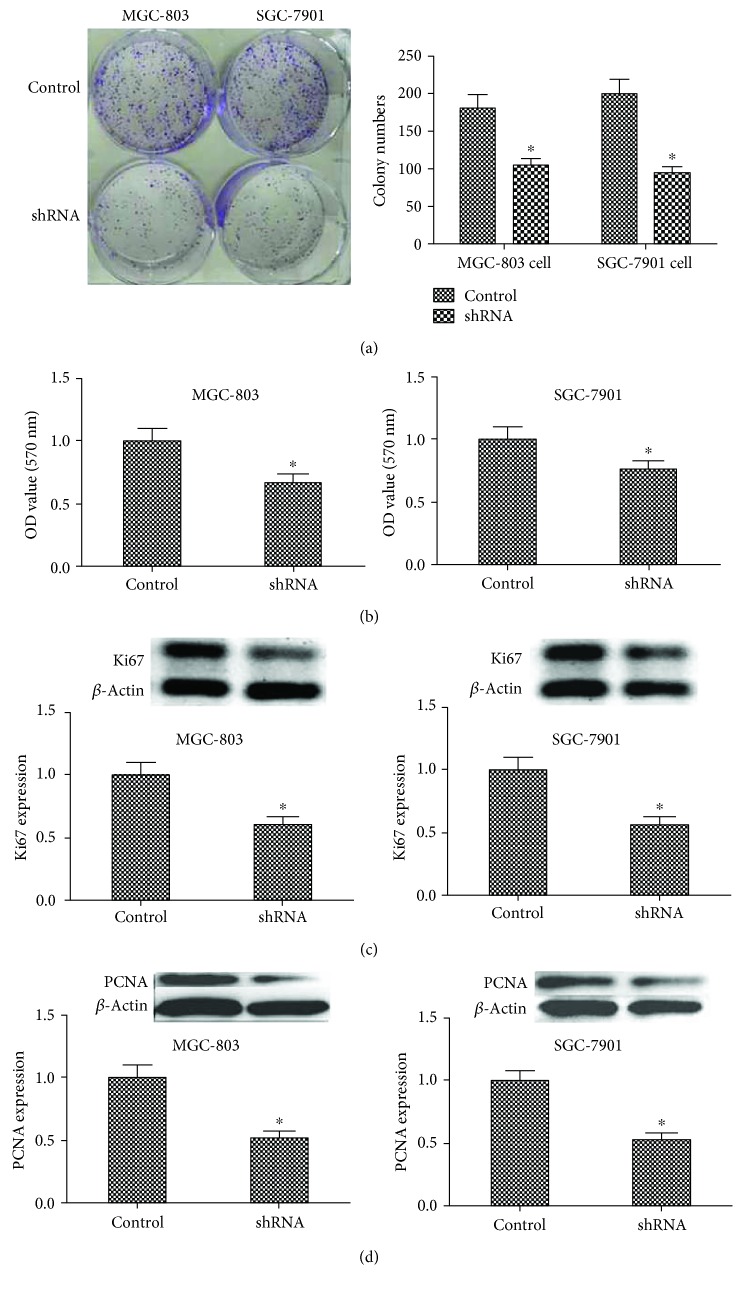
Knockdown of KIF23 significantly inhibited the proliferation in gastric cancer cells. (a) Photographs of the colony formation assay showed MGC-803 (a) and SGC-7901 cells (b) that were transfected with the control or KIF23 shRNA. Cultivation lasted 2 weeks. (b) The MTT assay revealed the difference between the control and KIF23-depleted gastric cancer cells. (c) The western blot assay showed that the expression level of Ki67 was markedly decreased in MGC-803 and SGC-7901 cells. (d) The western blot assay revealed that the PCNA expression was significantly downregulated in MGC-803 and SGC-7901 cells. Results are presented as mean ± SD (∗P < 0.05).